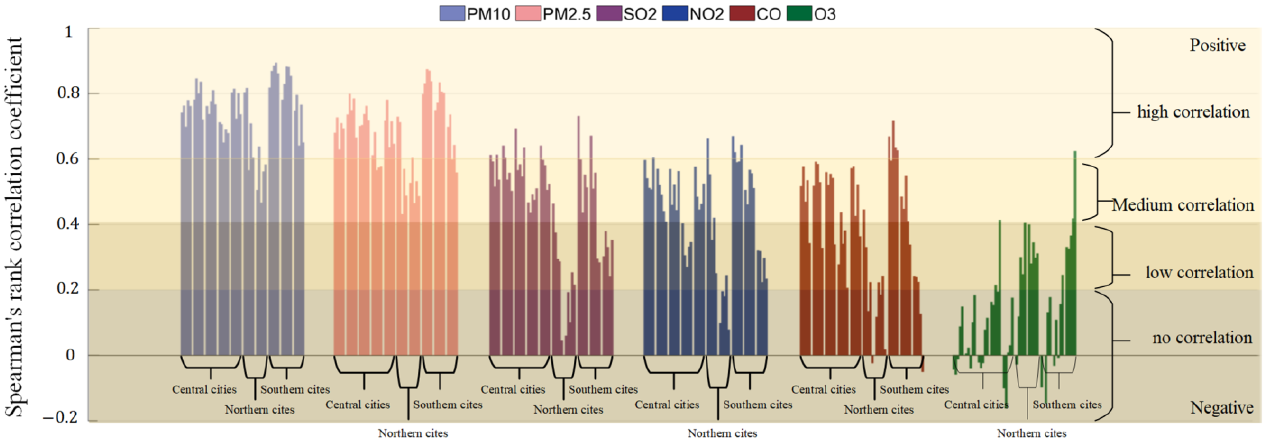
Figure 4. The correlation coefficients between the 6 pollutants and air quality improvements in